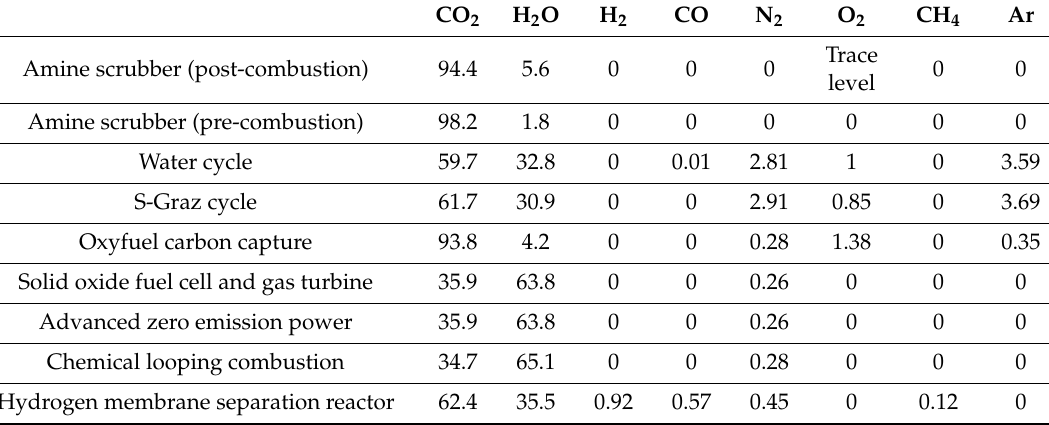
Table 2. Typical compositions following capture and separation processes